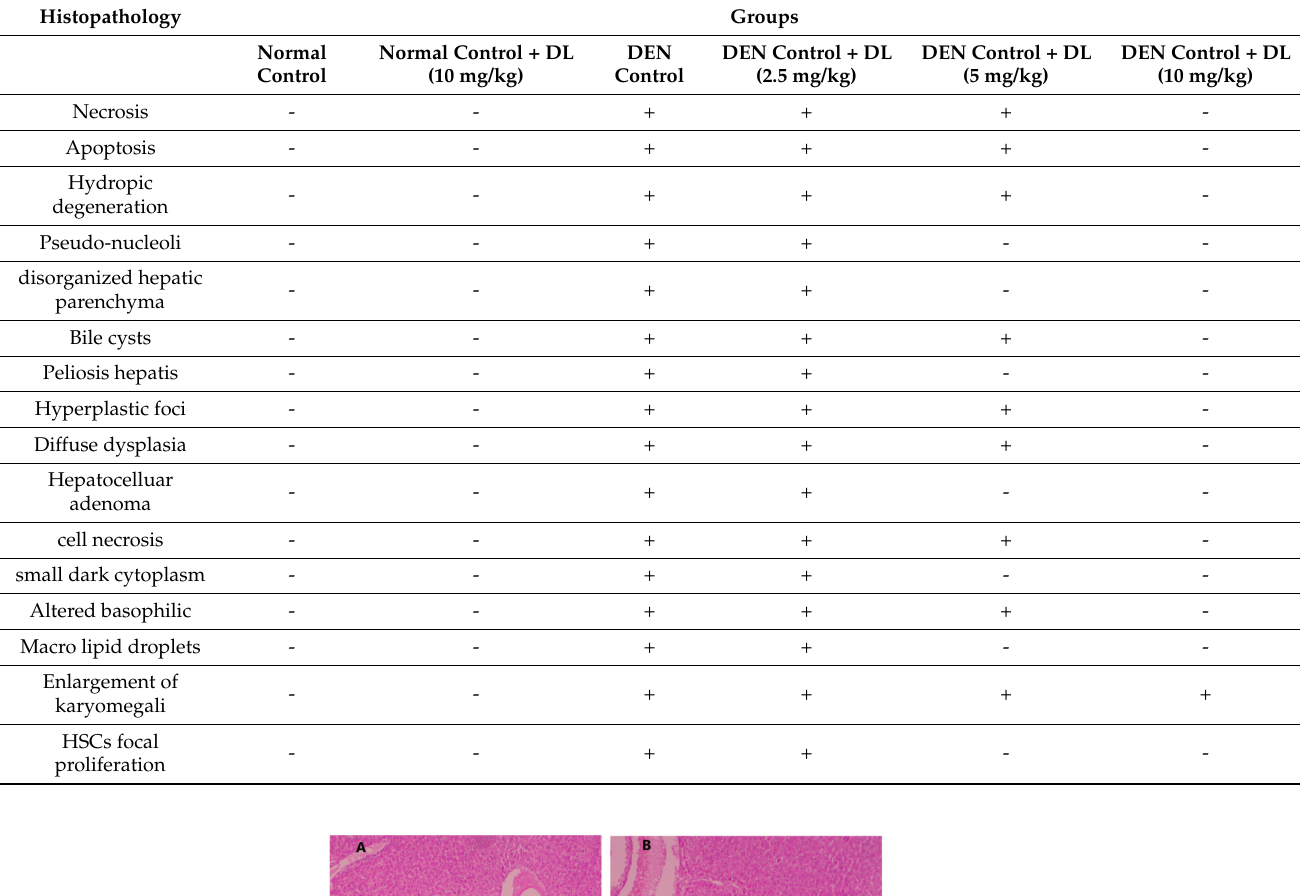
Table 7. Effect of debelalactone on DEN-induced hepatocarcinogenesis in rats.